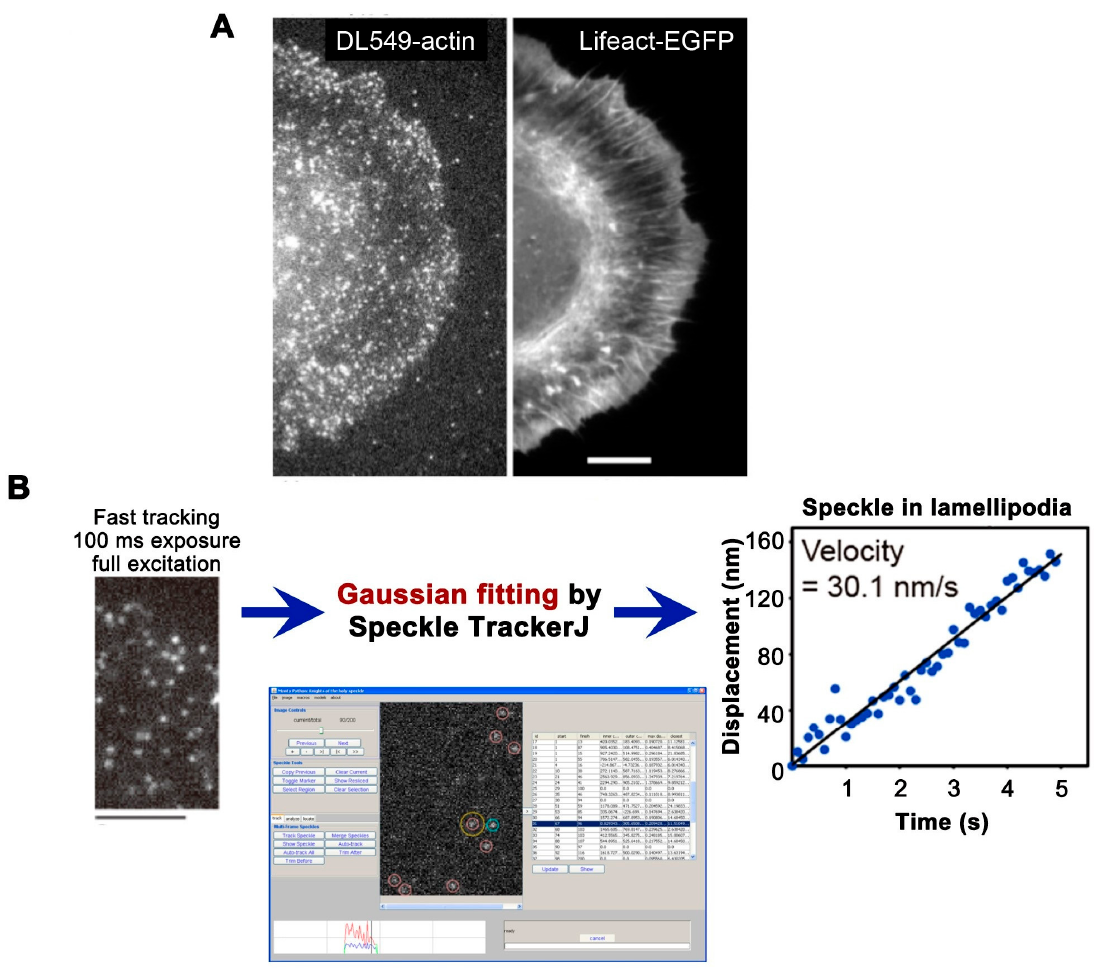
Figure 2. ( A ) Live Electroporation-Based SiMS Microscopy (eSiMS) image of DL550-actin in lamellipodia of XTC cells loaded with DL550-actin by electroporation (left) and actin structures visualized by Lifeact-EGFP (enhanced green fluorescent protein) (right). Bar = 10 μ m. ( B ) Nanometer-scale displacement analysis in cells with DL549-actin. DL549-actin speckles are acquired with a 100 ms exposure time and a full 100 W mercury excitation (left), and then localization of the SiMS centroid is determined by using the Gaussian fit model of Speckle TrackerJ (middle). The graph (right) is displacement plot of the central position of a DL549-actin SiMS in lamellipodia in the series of images acquired as the right image. Bar = 5 μ m. Modified from Yamashiro et al., 2014 [33].